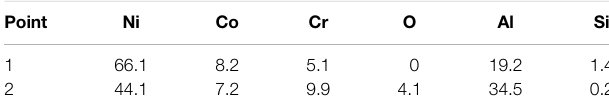
TABLE 2 | The chemical compositions (in at. %) of points in Figure 4 by EDS.